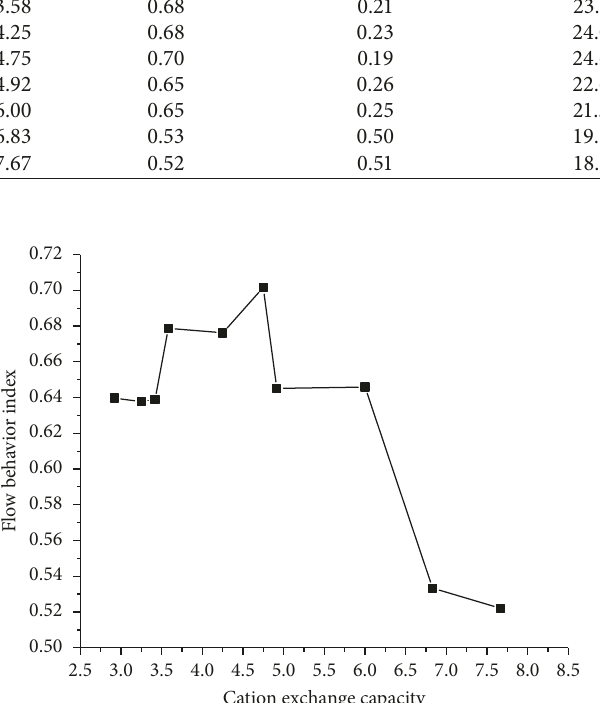
Figure 6: Curve of flow behavior index of slurry fluid.